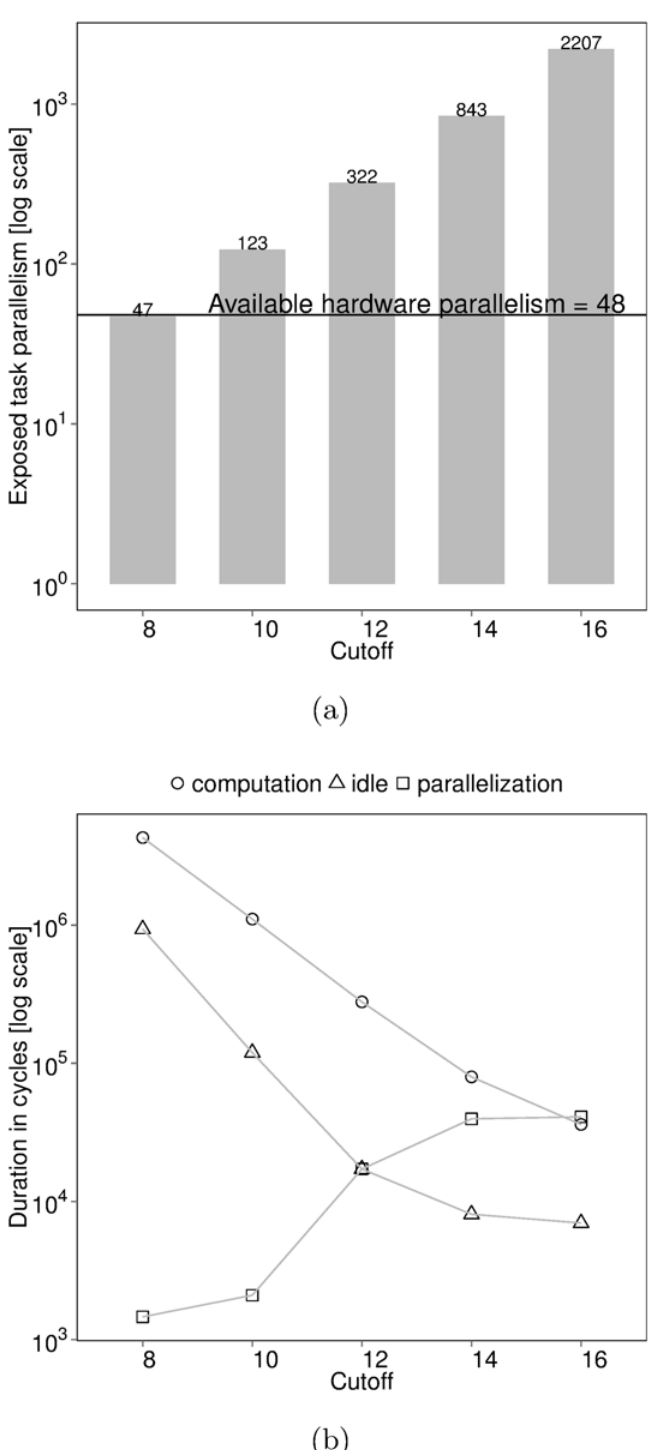
Fig 2. Task-based performance of BOTS Fibonacci. Input: n = 48, depth cutoff = {8,10,12,14,16}. Executed on 48 cores of a machine with four 12-core AMD Opteron 6172 processors running at highest frequency with frequency scaling turned off. The task scheduler used balances load using thread-private task queues and random work-stealing. (a) Task parallelism exposed during execution. We calculate task parallelism by dividing total task computation by the length of the critical path of the task graph. The